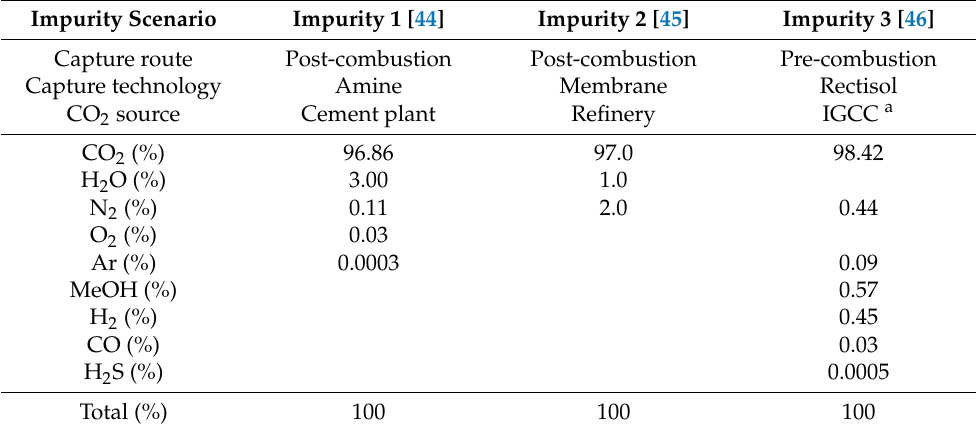
Table 1. Molar composition of the CO 2 streams in scenarios 5 to